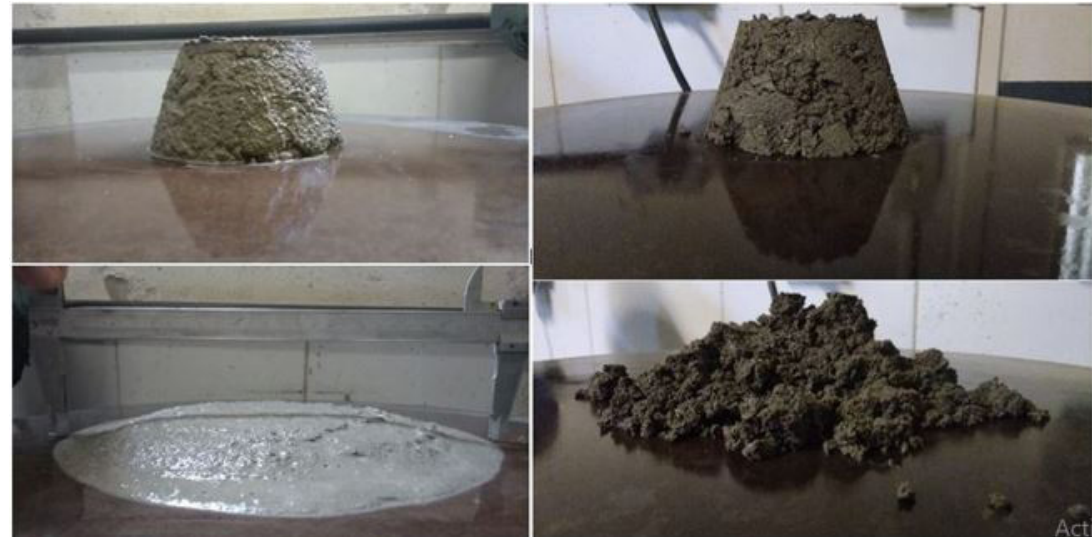
Figure 3. Comparison between the consistency of REF-02 and AF100-02 mortars.